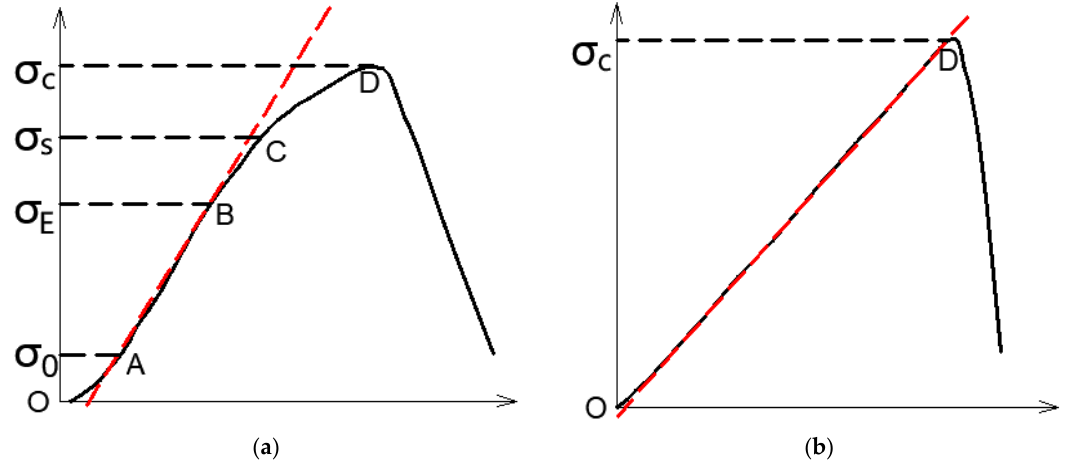
Figure 10. Stress–strain curves of rock under static and dynamic loads. ( a ) Static load; ( b ) Dynamic load.